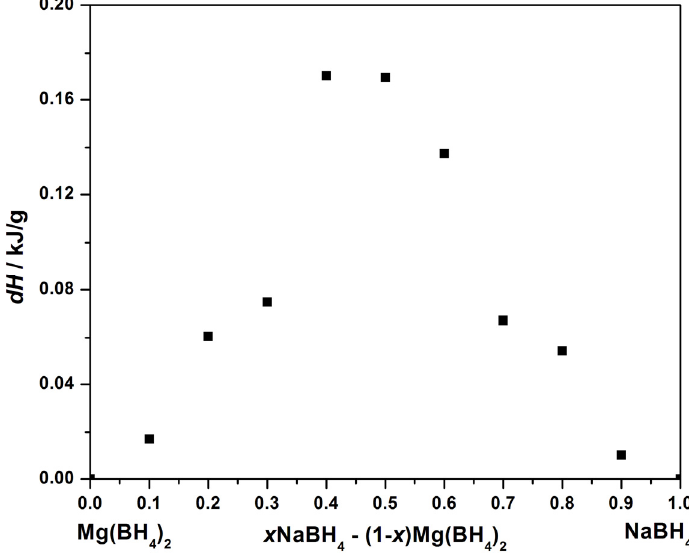
Figure 2. Integrated DSC signal in the temperature range 203 to 214 °C of the endothermic event per sample mass for x NaBH 4 –(1 − x )Mg(BH 4 ) 2 , x = 0 to